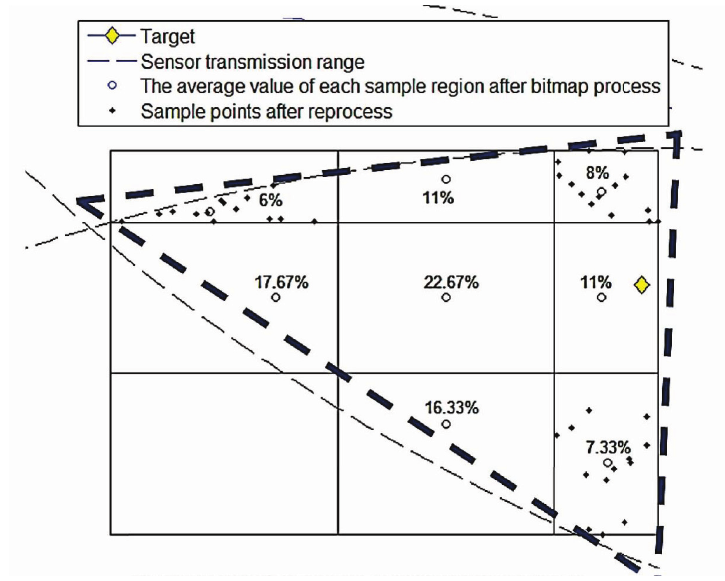
Figure 11. The external contour of the sample region and the distribution of the decompressed